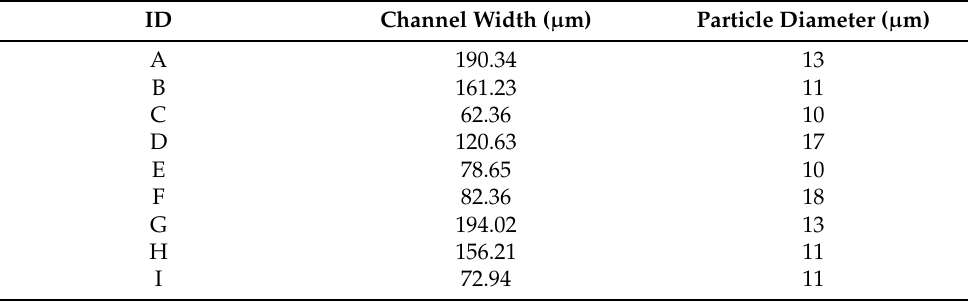
Figure 5. The nine randomly selected simulation results showing the comparison between ANN- predicted and COMSOL-predicted particle trajectories. Table 2. The detailed parameters of nine randomly selected